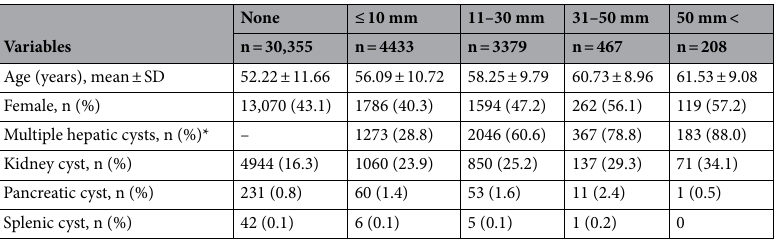
Table 1. Demographics and ultrasonographic findings according to hepatic cyst size. SD standard deviation. *Number information was missing in 12 cases (8: ≤ 10 mm, 3: 11–30 mm, and 1: 31–50 mm).